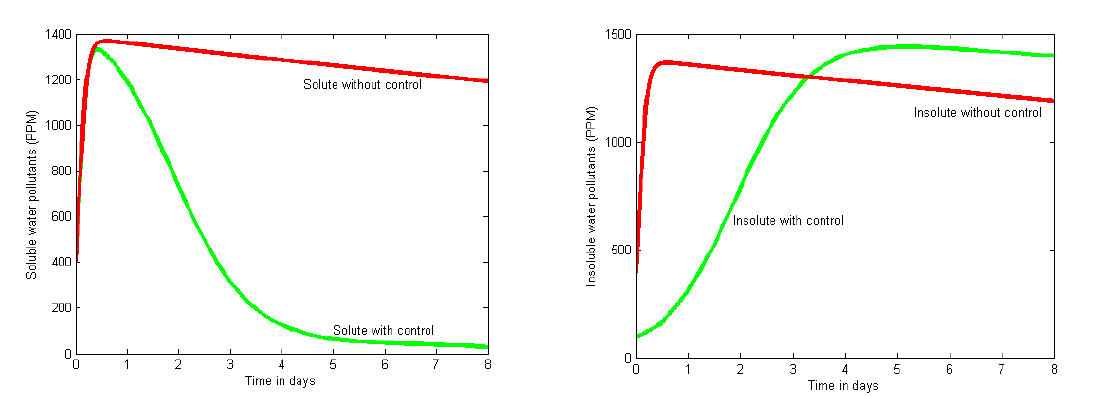
Fig. 6(a). Soluble water pollutants with and without control